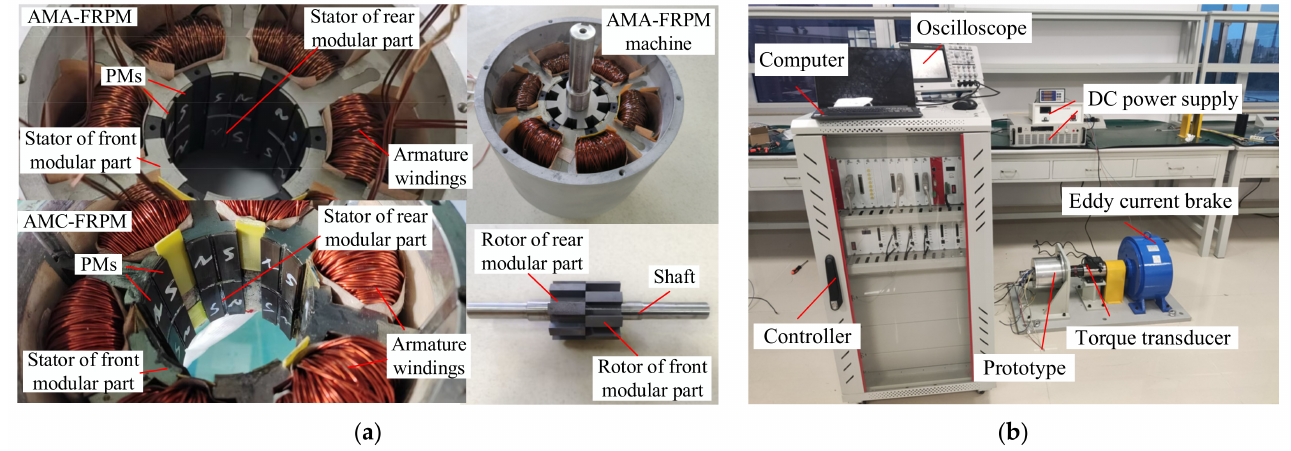
Figure 21. Prototypes and experiment platform. ( a ) Prototype machines. ( b ) Experiment